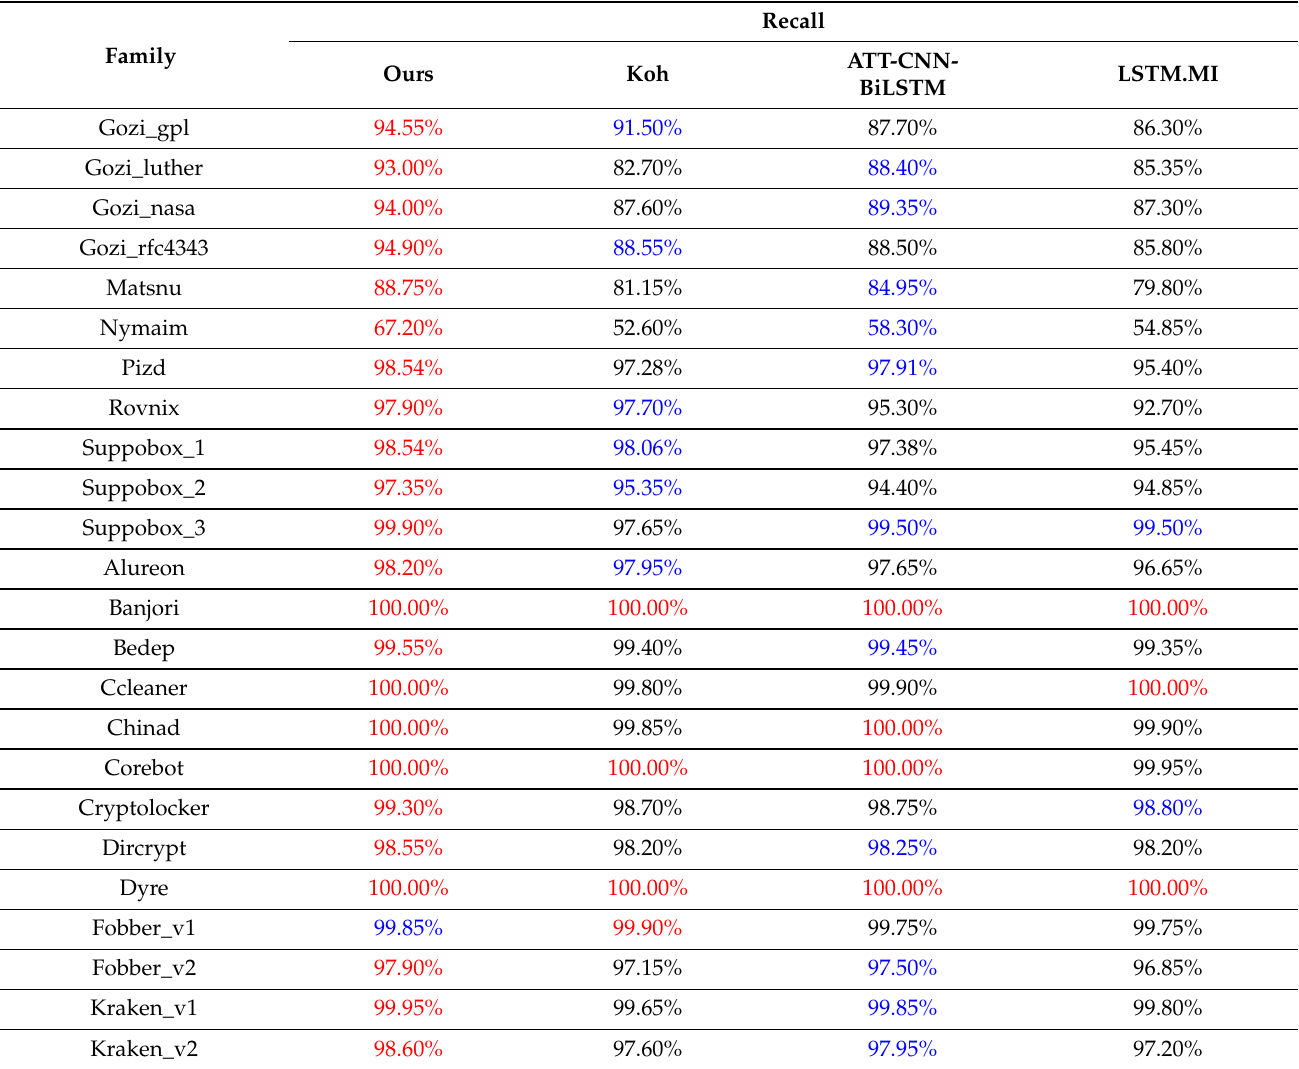
Table 4. Comparison of recall of different